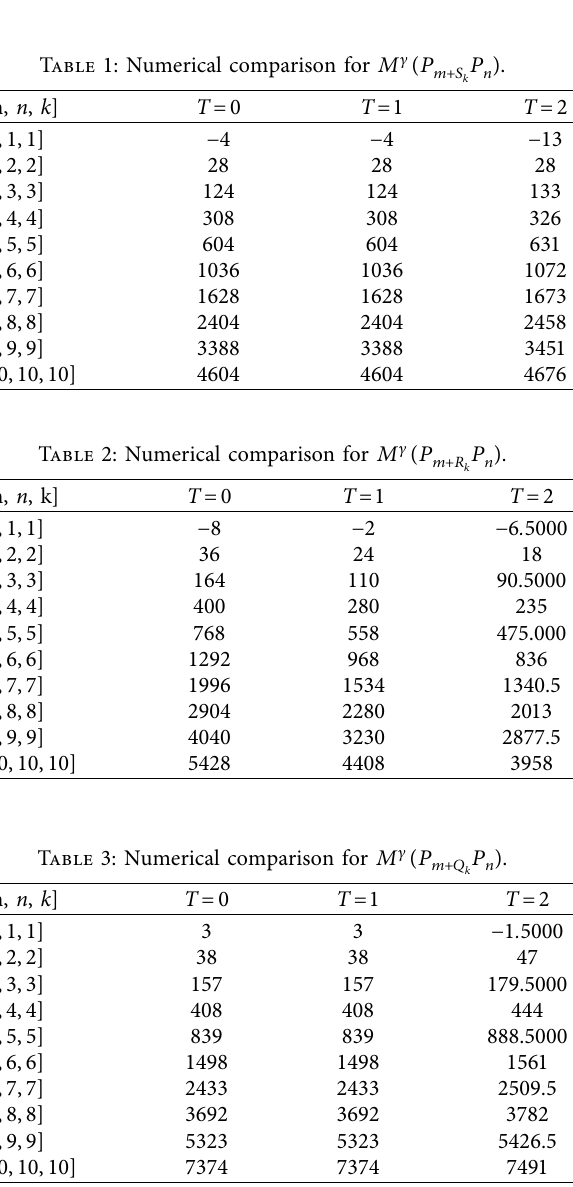
Table 4: Numerical comparison for M c ( P